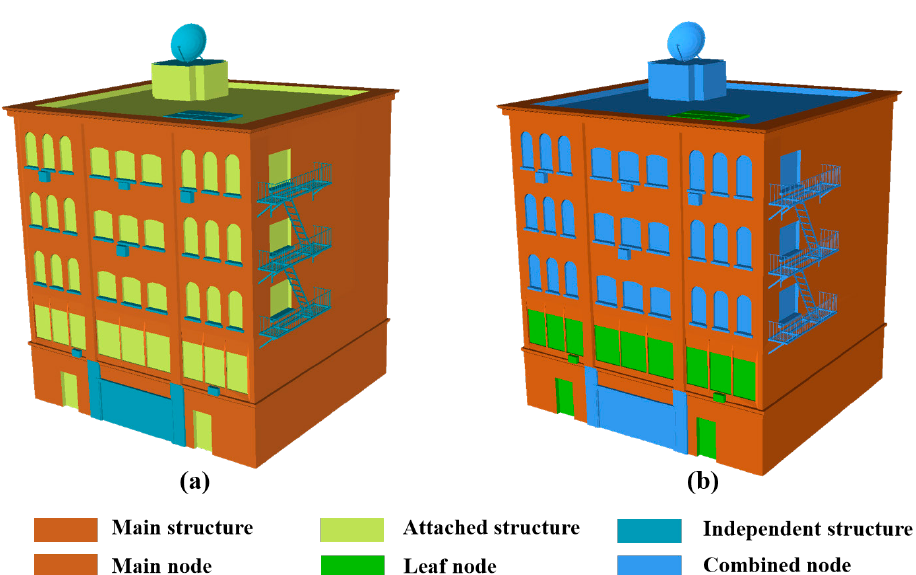
Figure 8. Results of constructing transmission nodes. ( a ) Structure extraction results, and ( b ) construction results of transmission nodes.